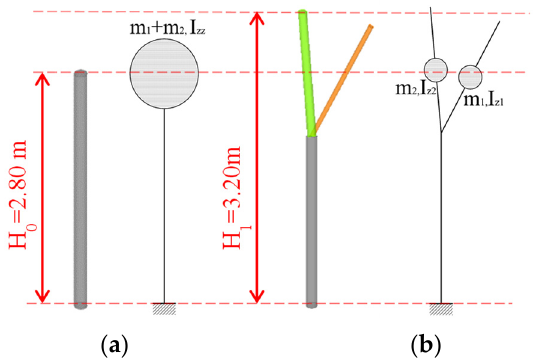
Figure 2. The two preliminary FE models adopted: ( a ) analytical model and the FE models: Model-0, ( b ) Model-1. Table 2. Results of the preliminary FE models in terms of resonant frequency (f), percentage of participating mass in the x-direction M x (%), percentage of participating mass in the y-direction M y (%), percentage of participating mass around z-axis M z (%), and the sum of the participating mass